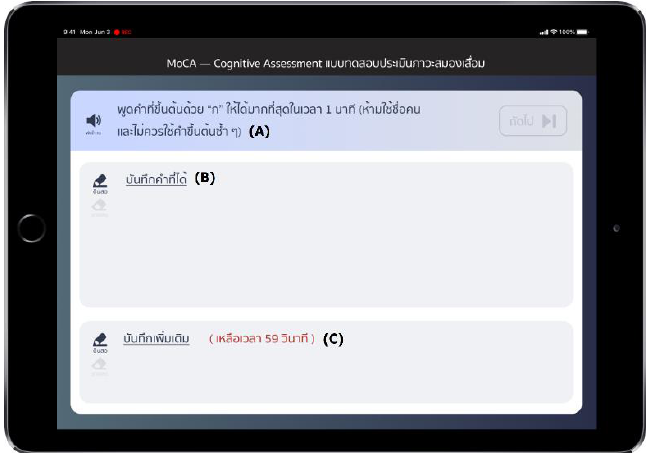
Figure 2. The PVF test in the MoCA application. ( A ) The application will read the PVF instructions